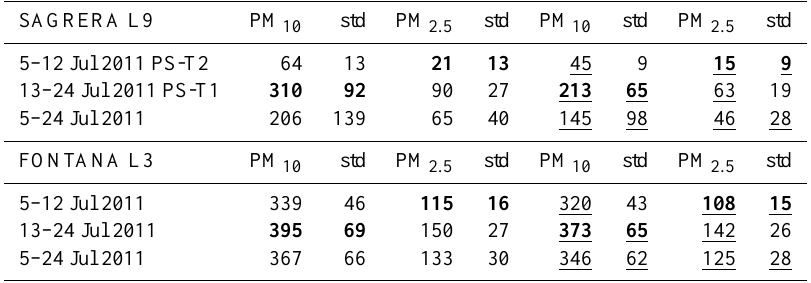
Table 2. Mean levels and standard deviation (std) of PM x (µgm − 3 ) from gravimetric measurements at the Sagrera (L9) and Fontana (L3) platforms from 08:30a.m. to 08:30p.m. Values highlighted in bold are deduced from gravimetric PM 10 or PM 2 . 5 by applying PM 2 . 5 /PM 10 ratios of the respective sampling period. The underlined data in the right hand of the table are the levels corrected by factors of 1.42 and 1.06 to represent the exposure across the whole S-L9 and F-L3 platforms, respectively, as explained in the methodology section. PS, summer platform ventilation, T1 and T2, usual and double tunnel ventilation power.